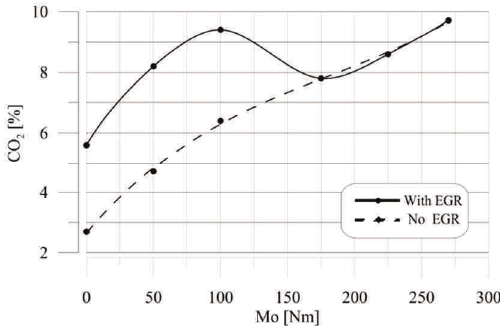
Fig. 21. Influence of the engine load on the CO 2 concentration in exhaust gases for engine operating with/without EGR